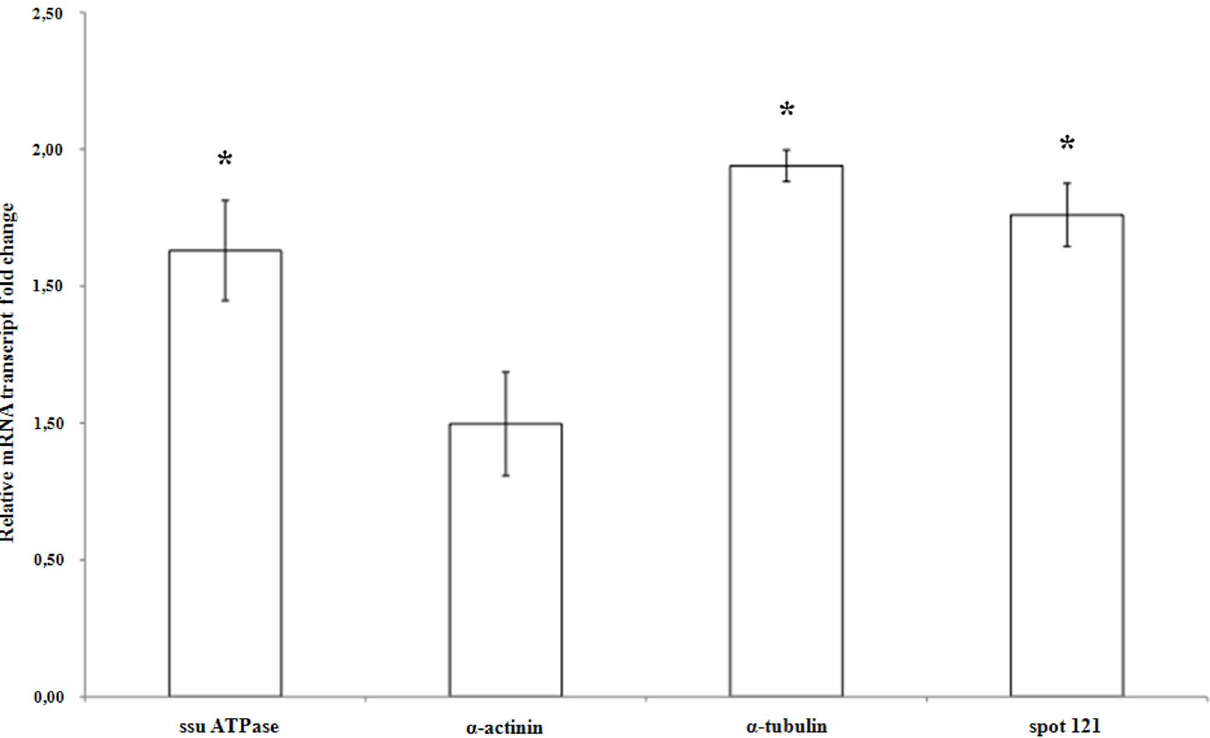
Figure 4. Relative amounts of the a subunit of ATPase (ssu a ATPase), a actinin, a tubulin and protein spot 121 transcripts in N -3- oxododecanoyl- L -homoserine lactone (3-oxo-C 12 -HSL)-stimulated Suberitesdomuncula compared to the control. The mRNA levels in stimulated S. domuncula were evaluated by quantitative reverse transcription-PCR and compared to non-stimulated sponges. Reactions were performed in triplicate with three different specimens. Relative mRNA level values resulted from calculating values: values above and below 1 show a higher and a lower mRNA level in the presence of 10 2 6 M 3-oxo-C 12 -HSL, respectively. Significant expression changes (p , 0.05) in the presence of N - 3-oxododecanoyl- L -homoserine are pointed out by an asterisk. doi:10.1371/journal.pone.0097662.g004 PLOS ONE |